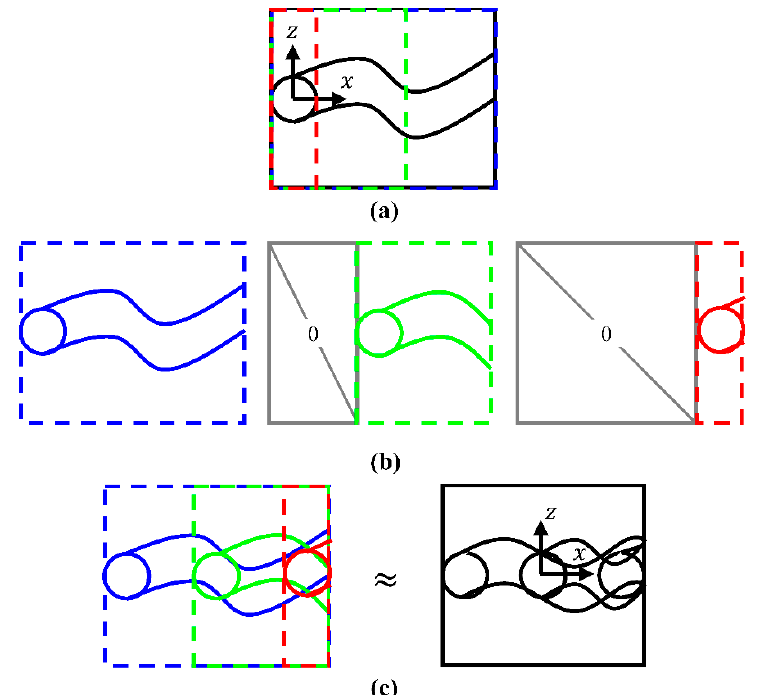
Figure 1. ( a ) Composite sub-domains extracted from the single jet velocity field data, ( b ) clear depiction of each sub-domain and appended null matrices, and ( c ) representation of the overlaid sub-domains to approximate the tandem jet array’s experimentally measured flow physics. Color legend: black— ‘true’ measurement data, blue—sub-domain of jet 1, green—sub-domain of jet 2, and red—sub-domain of jet 3 based on current available field of view.